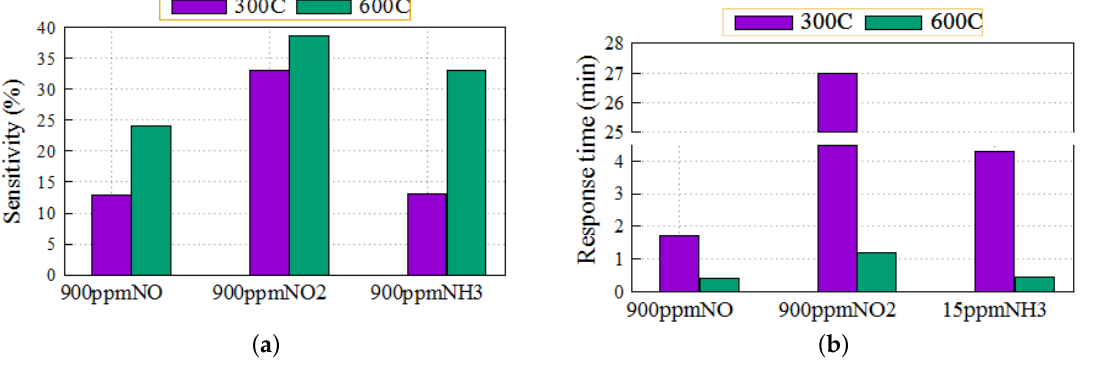
Figure 9. Comparison of the performances of the sensor ( a ) sensitivity; and ( b ) response time, as a function of operation temperature (300 °C and 600